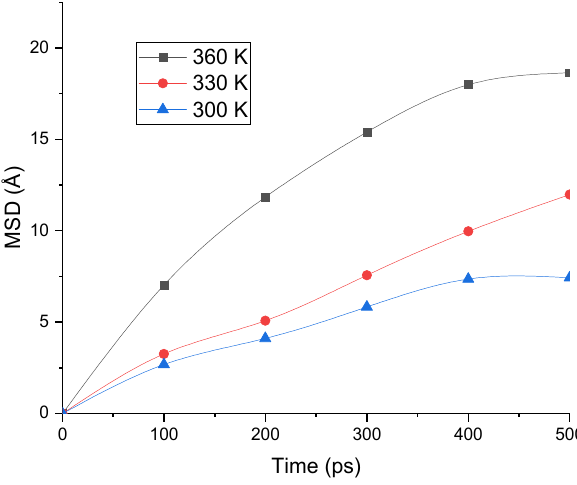
Figure 8. MSD curves for NGOs at different temperatures.